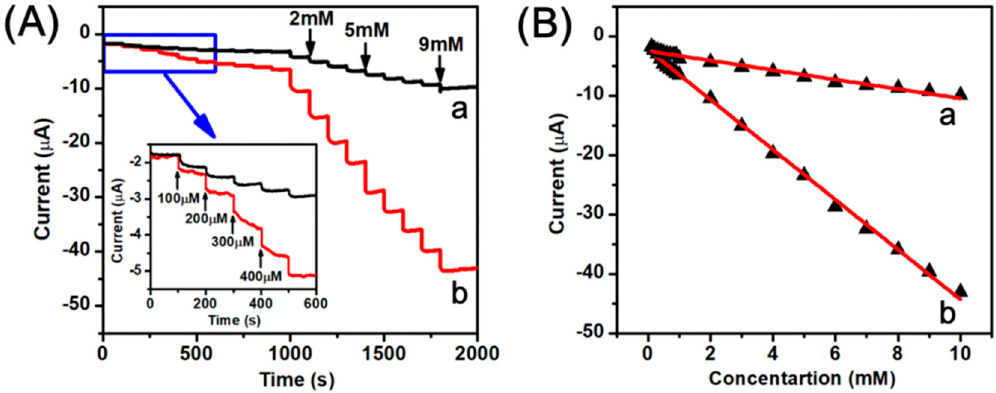
Figure 7. ( A ) Amperometric response of the AuNPs/RGO (a) and the Ag-AuNPs/RGO (b) sensors upon successive addition of H 2 O 2 into 0.1 M PBS, pH 7.2 under a stirring condition, applied potential − 0.2 V. The inset was the amplification of curve with the lower concentration region; ( B ) The linear relationship between different H 2 O 2 concentration and reduction current. Table 1. Comparison of analytical performance of Ag-AuNPs-RGO modified electrode with previously reported similar modified electrodes for the detection of H 2 O 2 .